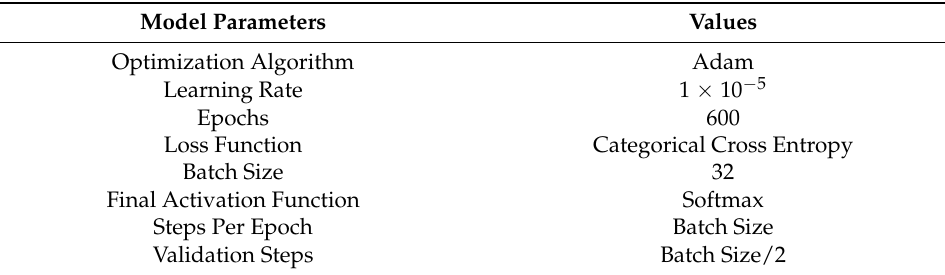
Table 4. List of parameters used in designing the